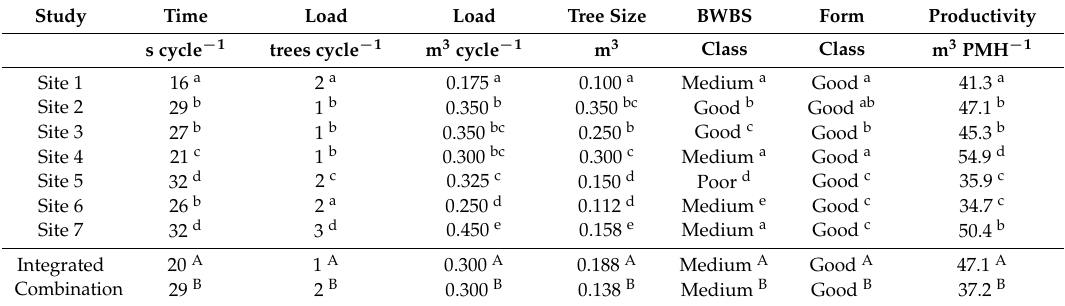
Table 4. Study results: median values and statistical significance of differences extracted from the whole dataset.